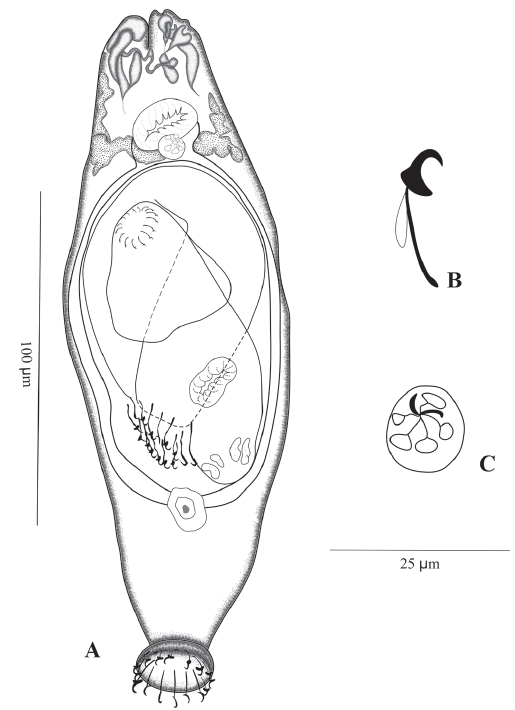
Figure 2. Anacanthocotyle anacanthocotyle Kritsky & Fritts, 1970. (A) Composite drawing of whole-mount (ventral view); (B) Hook; (C) Male Copulatory organ (MCO).